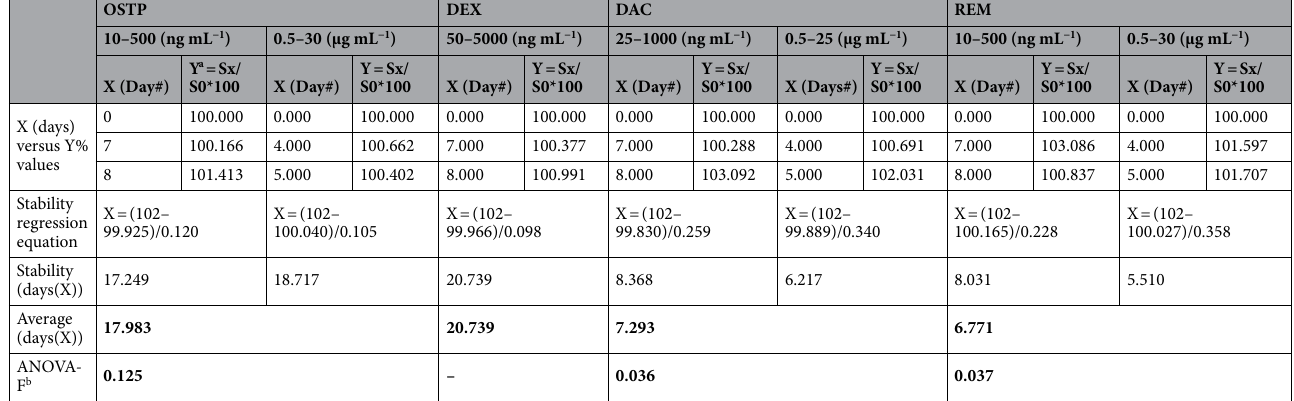
Table 5. Stability of oseltamivir phosphate, dexamethasone, daclatasvir dihydrochloride, and remdesivir in freezer. Significant values are in bold. a (S0) represents the slope of the regression equation of the standard solutions on the first day, whereas (Sx) represents the slope of the same standard solutions on a different day. b Calculated F, ANOVA test for equivalence study between proposed methods (grouped by column), ANOVA- F-critical = 7.709 (alpha =